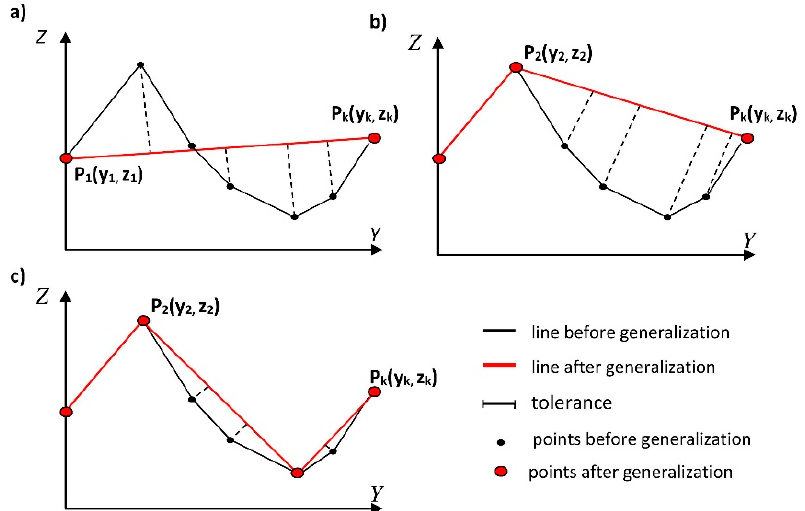
Figure 2. Principle of operation of the Douglas–Peucker (D-P) method (source: study based on Douglas and Peucker (1973) [40]).